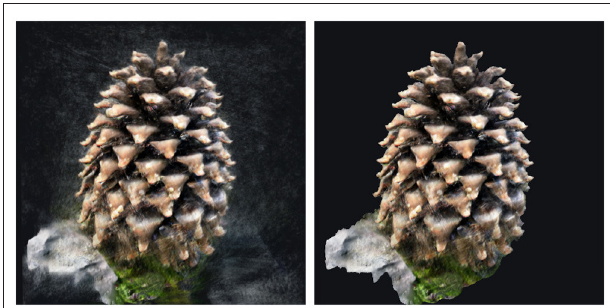
Algorithm 3 | The backtracking algorithm used to find a